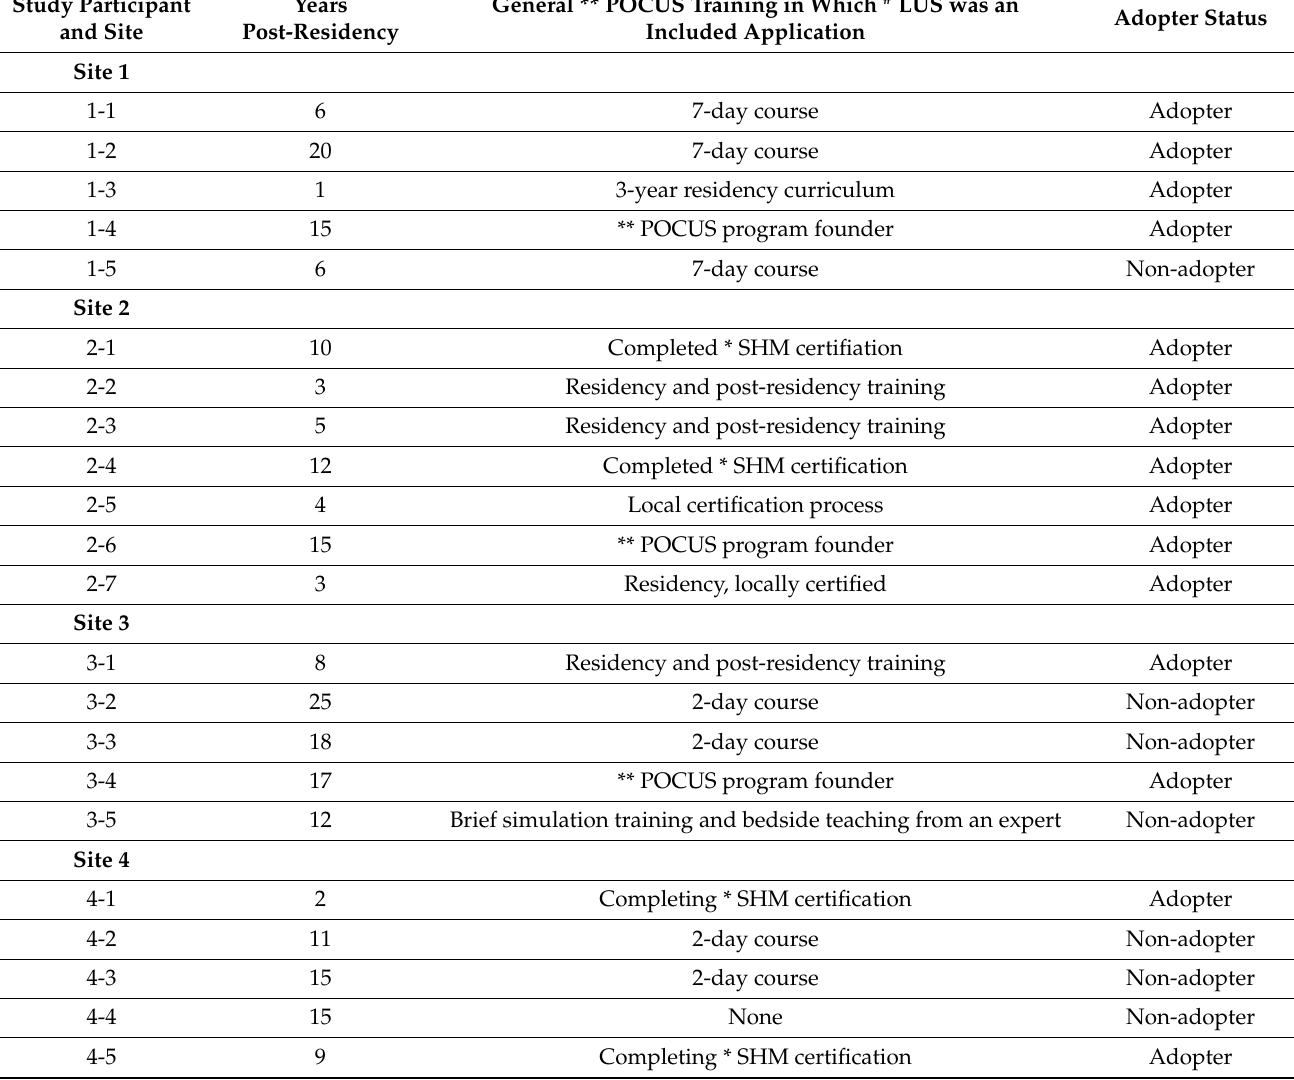
Table 2. Characteristics of Participants.